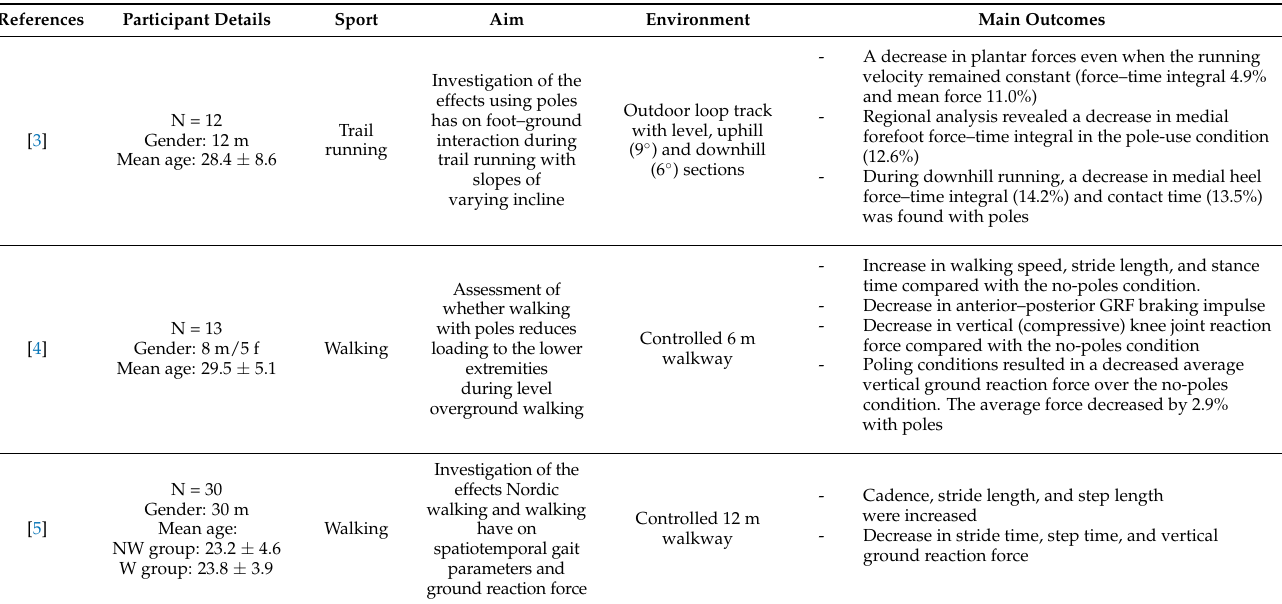
Table 1. Biomechanical aspects of pole use .